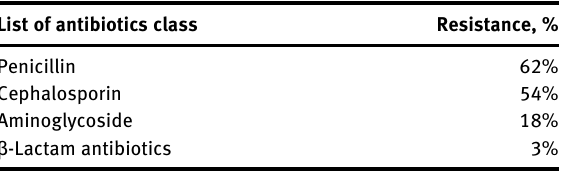
Table  : Resistance pro fi le of Gram negative isolates among control group